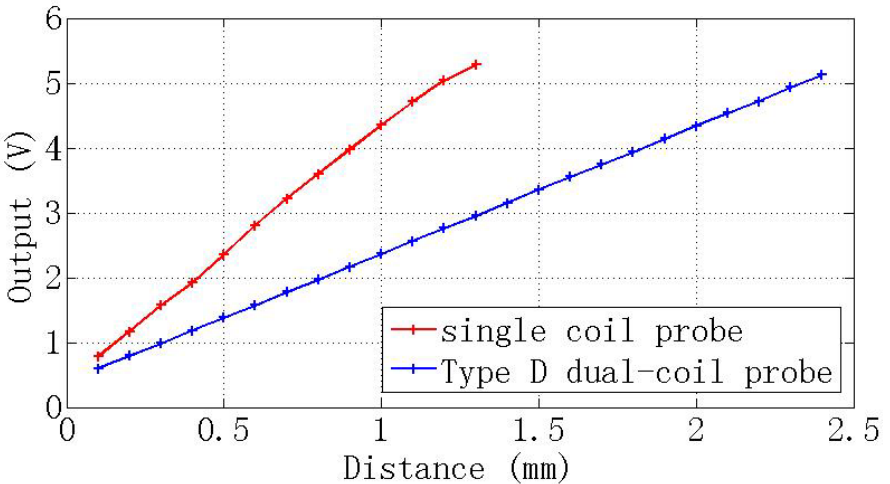
Figure 14. The output voltage V ( x ) of the ECDS.